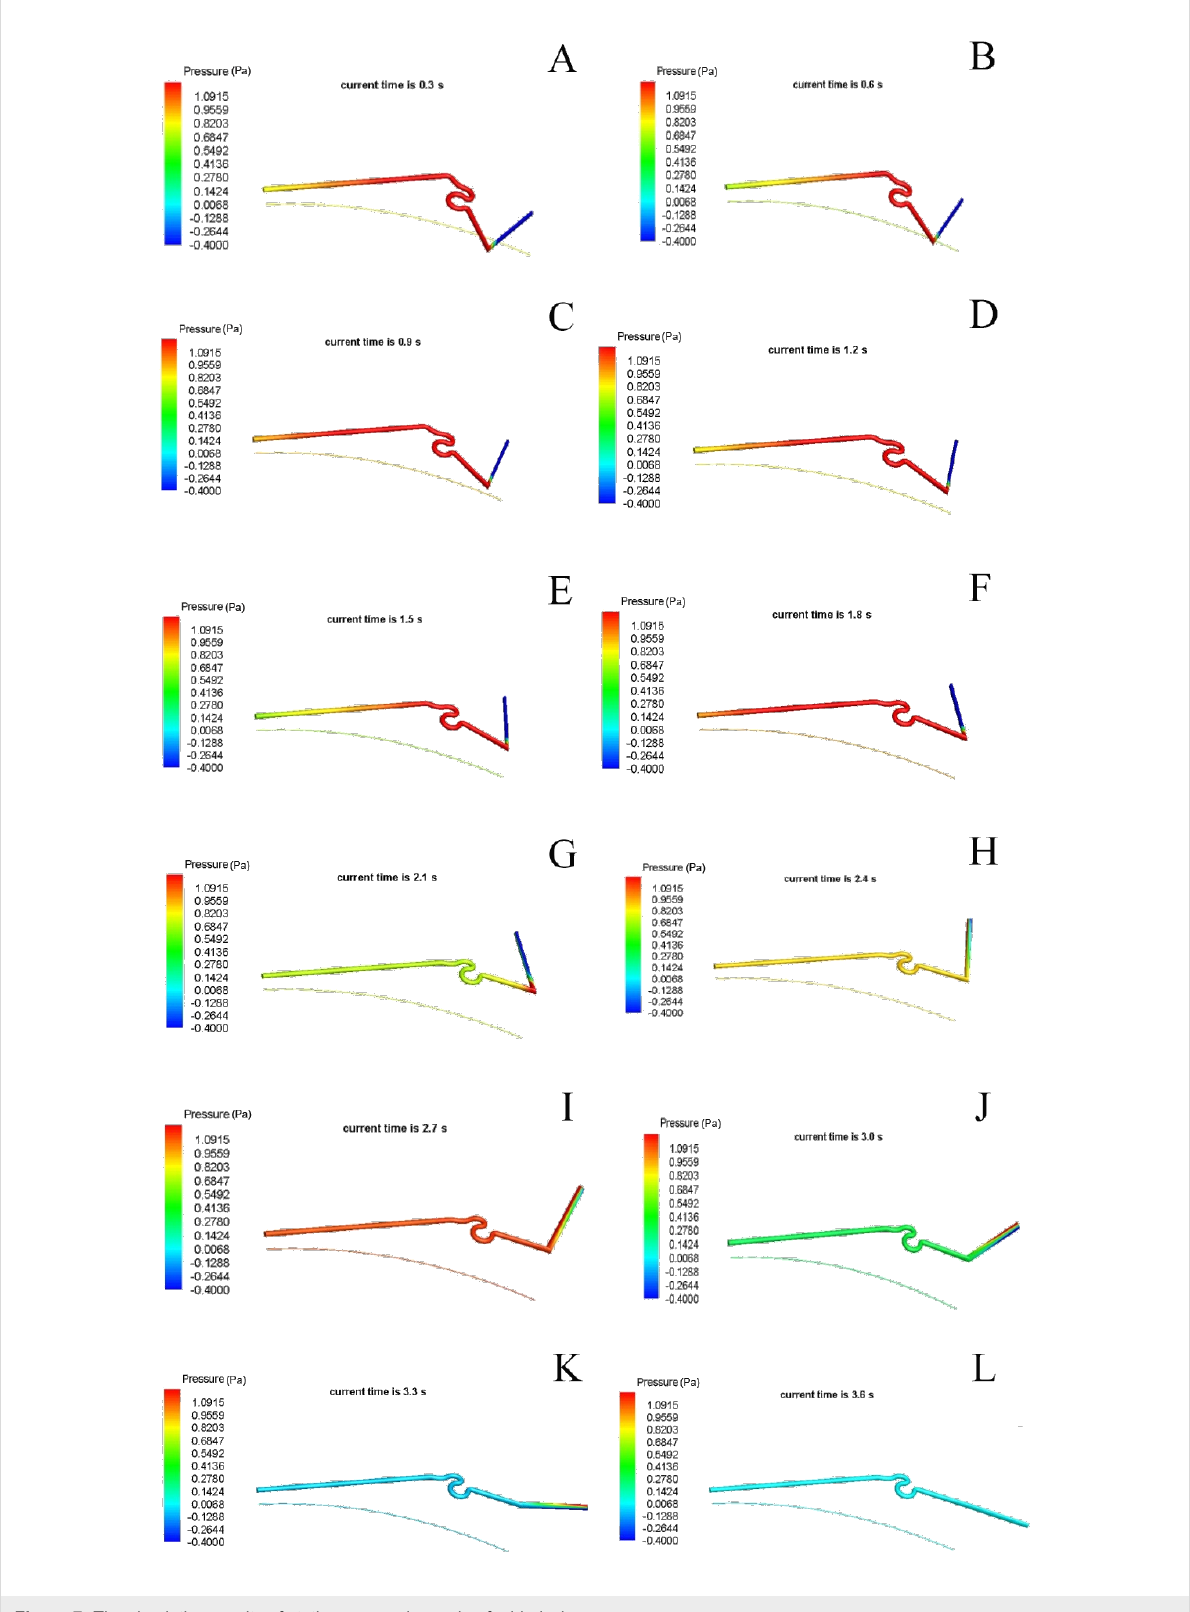
Figure 7: The simulation results of static pressure in a vein of a hind